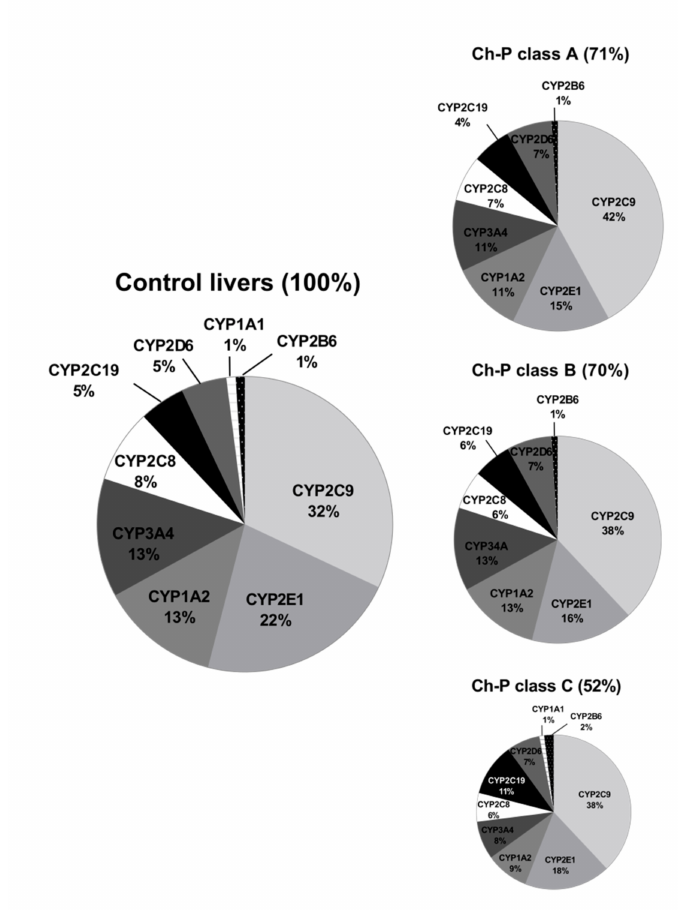
Figure 3. The pie chart of the individual enzyme proteins in livers stratified according to the Child– Pugh score (A, B, C class). The pie charts show the abundance of each enzymatic protein as a percentage of the sum of all enzyme proteins abundance. Percentages in brackets indicate a total enzyme protein abundance in comparison to the control livers (indicated as